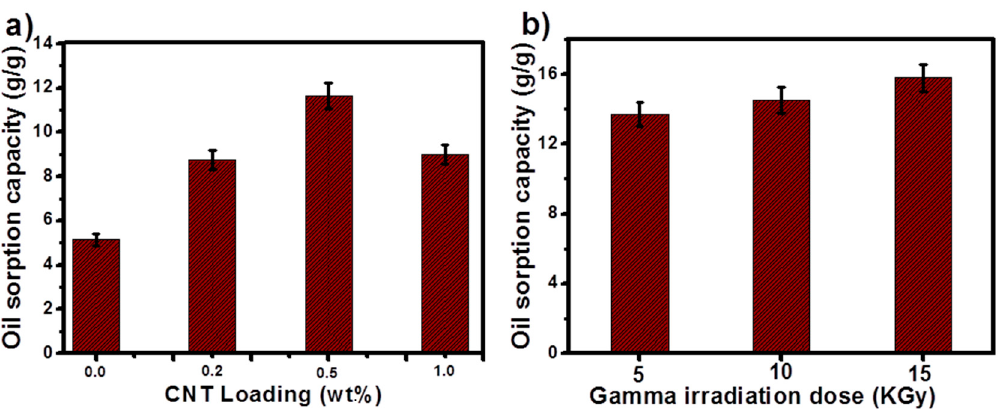
Figure 7. ( a ) Oil sorption capacity with different concentration of CNT (0.2, 0.5 and 1 wt.%), ( b ) with different irradiation doses.